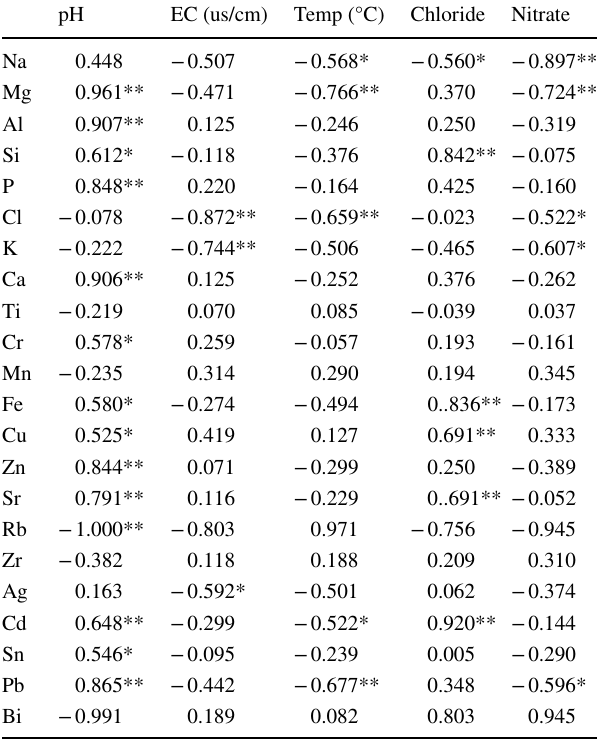
Table 4 Correlation between physicochemical parameters and ele- mental